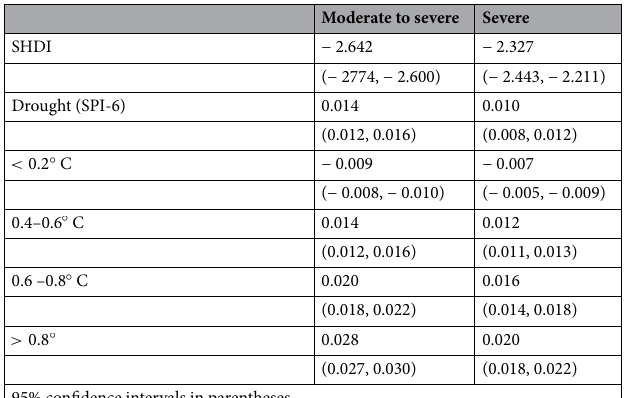
Counterfactual analysis: effects of climate change on food insecurity